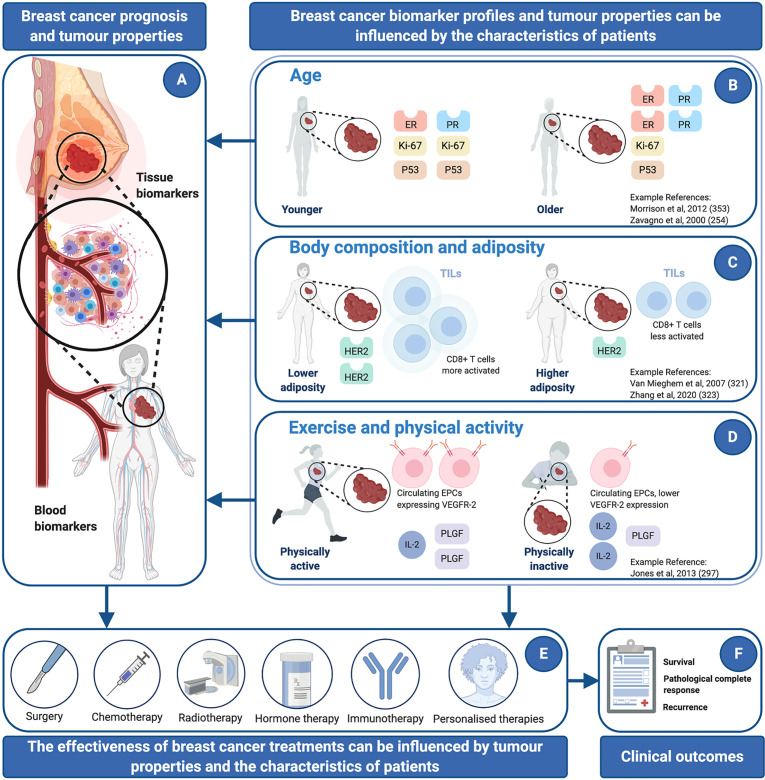
Breast cancer prognosis, tumor properties, and clinical outcomes can be influenced by the characteristics of patients, including: age, body composition and adiposity, or exercise and physical activity. References are considered to be representative examples of robust human studies with breast cancer patients. (A) Cancer biomarkers can be assessed in tumor tissue or in blood and can provide information about prognosis and the clinical response to different treatments. (B) Some studies have shown that older age is associated with lower expression of tumor proliferative markers (e.g., Ki-67) and proteins implicated in tumor progression (e.g., P53), and higher expression of certain hormone receptors (e.g., ER, PR). (C) Higher adiposity has been associated with a lower expression of HER2, a lower magnitude of tumor immune cell infiltration and lower activation status of tumor-resident CD8+ T cells. (D) Bouts of exercise and physical activity have been shown to decrease some inflammatory markers (e.g., IL-2) and increase pro-angiogenic factors (e.g., PLGF and EPCs expressing VEGFR-2). Higher tumor vascularity could facilitate the delivery of drugs to a tumor. (E) The effectiveness of breast cancer treatments can be influenced by tumor properties [shown in panel A] and the characteristics of patients [shown in (B–D)]. (F) In turn, interaction between tumor properties, the characteristics of patients, and the effectiveness of breast cancer treatments can influence clinical outcomes. EPCs: Epithelial Progenitor cells, ER: Estrogen Receptor, HER2: Human Epidermal Growth Factor Receptor-2, IL-2: Interleukin 2, IL-6: Interleukin 6, KI-67: nuclear protein Ki-67, PGLF: Placenta Growth Factor, PR: Progesterone Receptor, P53: tumor protein 53, TILs: tumor Infiltrating Lymphocytes, VEGFR-2: Vascular Endothelial Growth Factor Receptor-2. Figure created with BioRender.com. Adapted from “tumor Microenvironment 2” and “Types of Cancer Treatment”, by BioRender.com (2020). Retrieved from https://app.biorender.com/biorender-templates.